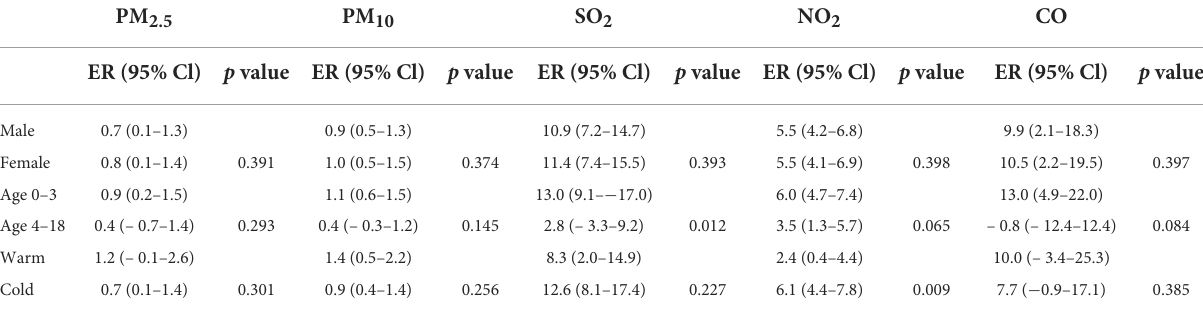
TABLE 3 Percentage changes with 95% confidence intervals (CIs) in AD outpatient visits stratified by gender, age and